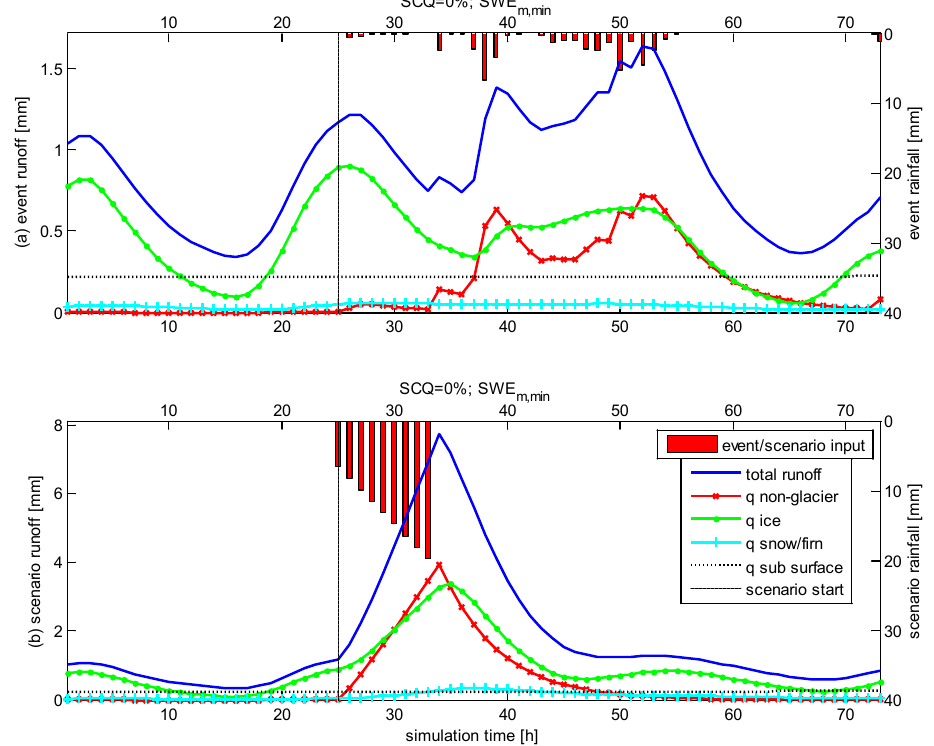
Fig. 7. Gepatschalm catchment: Simulation results with initial state conditions from 29 August 2003; SCQ=0% and SWE=SWE m , min . Simulation with (a) measured rainfall and (b) design storm ( T = 5000years, D = 9h) with increasing rainfall intensity.